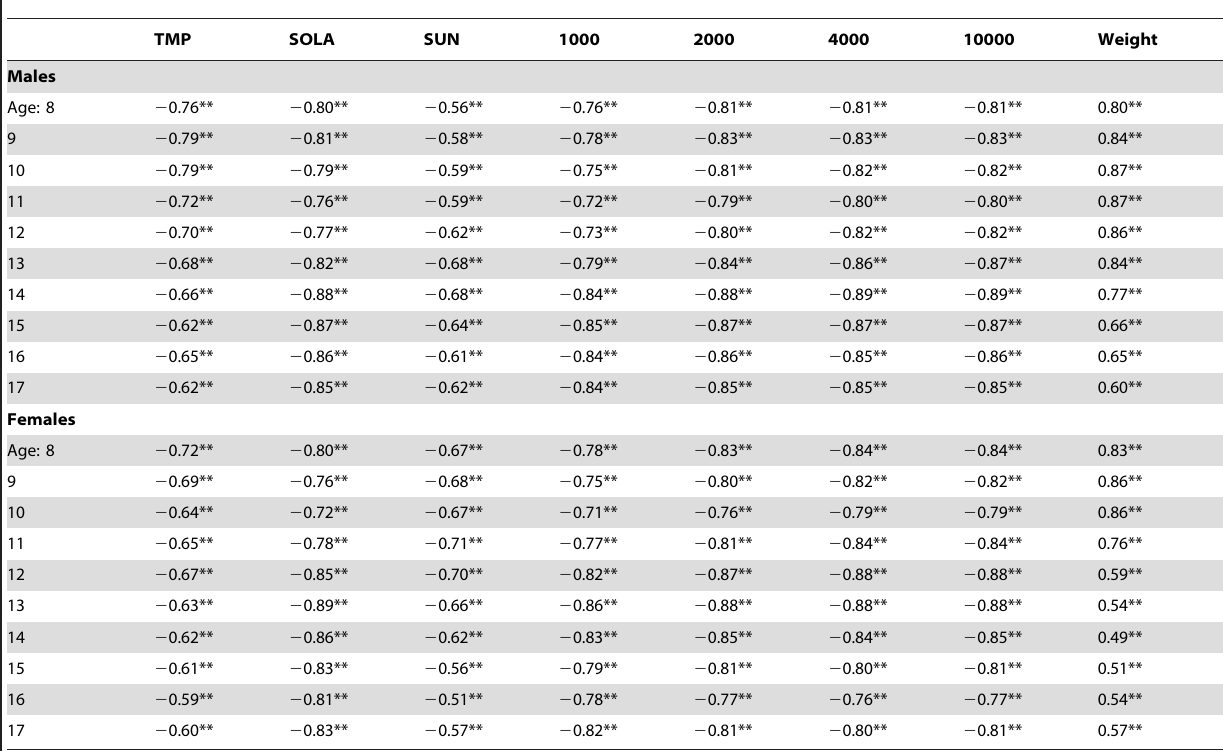
Table 4. Pearson’s correlation coefficients of the relationship between height and climatic